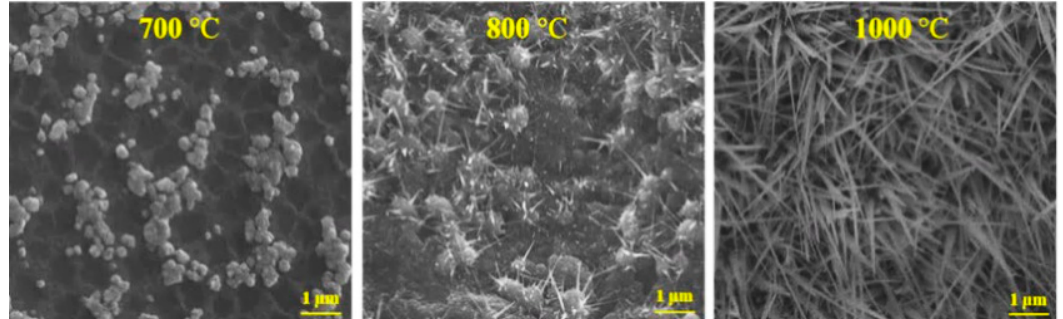
Figure 5. SEM images of Ga/Ag on quartz, which was oxidized at 700, 800, and 1000 °C. At 700 °C, phase segregation was observed, developing multiple nuclei of Ga 2 O 3 species. At 800 °C, the Ga 2 O 3 nanoparticles nucleation led to the Ga 2 O 3 nanowires. At 1000 °C, the growth of the nanowires was controlled by the presence of the dissolved oxygenated Ga species in the molten Ga.